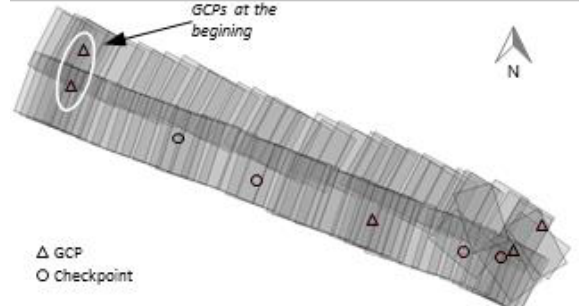
Figure 5. Image block geometry with 93 images, five GCPs, and four altimetry checkpoints.